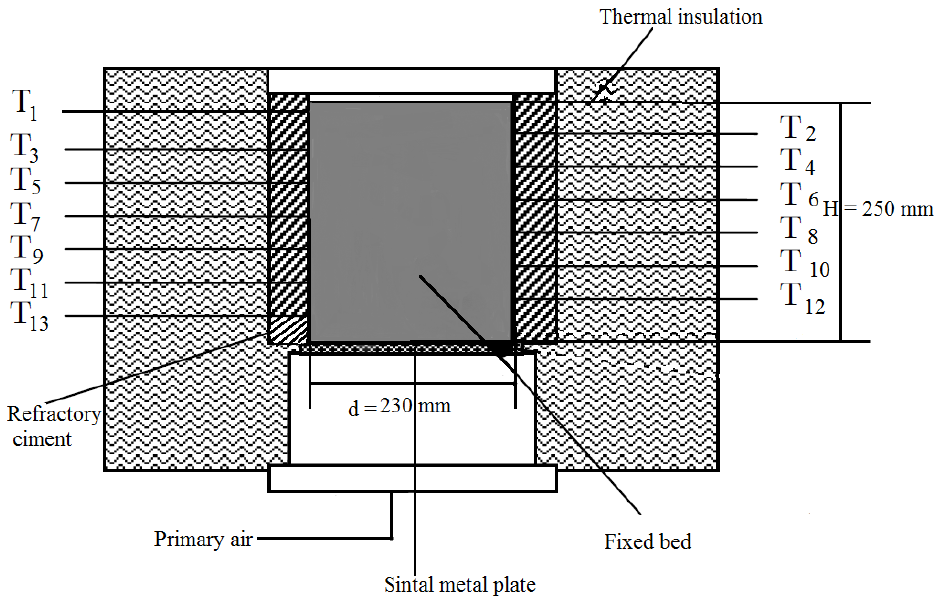
Figure 2. The fixed bed reactor and the thermocouples disposition.